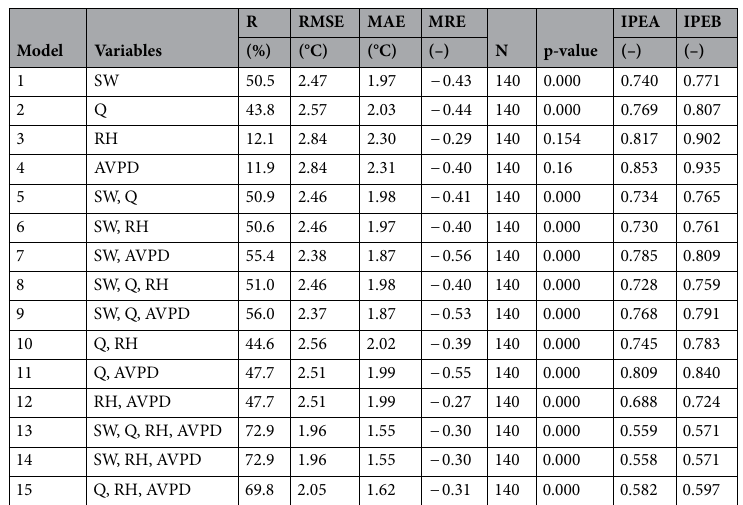
Table 12. Linear different models and statistical parameters for (T c − T a ) estimating. R is correlation coefficient; RMSE: root mean square error; MAE: mean absolute error; MRE: mean relative error; IPE: Ideal Point Error; N is the number of measurements.